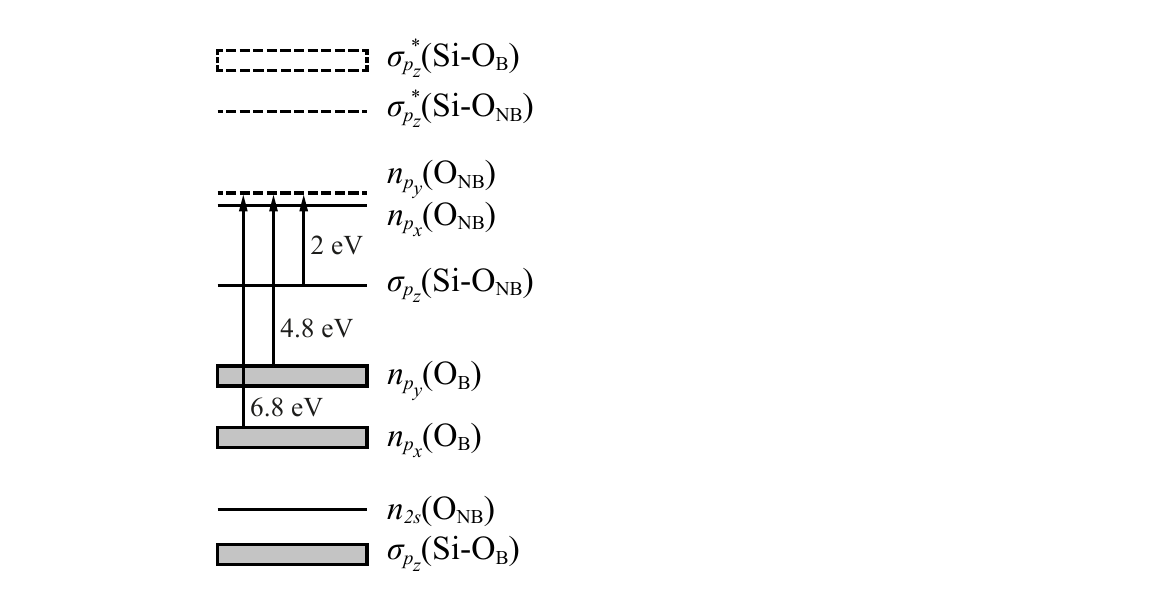
Figure 6. Energy level diagrams of a non-bridging oxygen hole center. Vertical arrows correspond to optical transitions between bondind and non-bonding orbitals, while grey boxes represent multiply degenerated levels. Adapted from Suzuki et al.